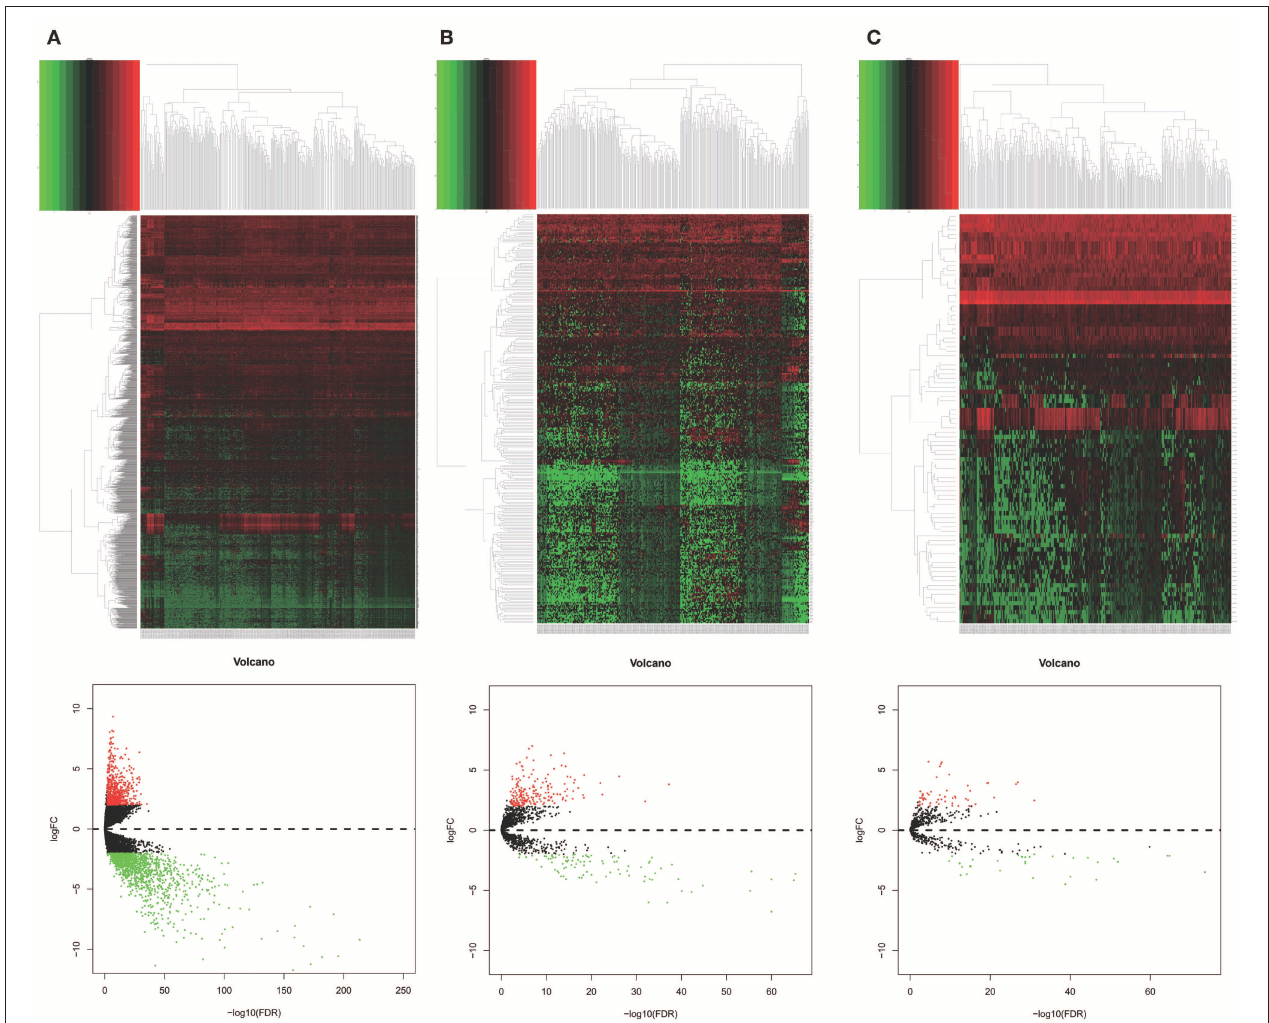
FIGURE 1 | Distributions of differentially expressed genes in oral squamous cell carcinoma (OSCC) (|log2FC| > 2.0 and adjusted P -value < 0.01) between 316 tumor tissues and 32 normal tissues. The ascending normalized expression level in the heatmaps is colored from green to red. Red means gene upregulation, green indicates downregulation and black means normal expression. Furthermore, each column represents a sample and each row represents a differentially expressed gene. The heatmaps plot 1919 DEmRNAs (A) , 192 DElncRNAs (B) , and 111 DEmiRNAs (C) . Similar with heatmaps, red stands for upregulations, green stands for downregulation and black stands for normal expression in volcanoes. Each point represents a